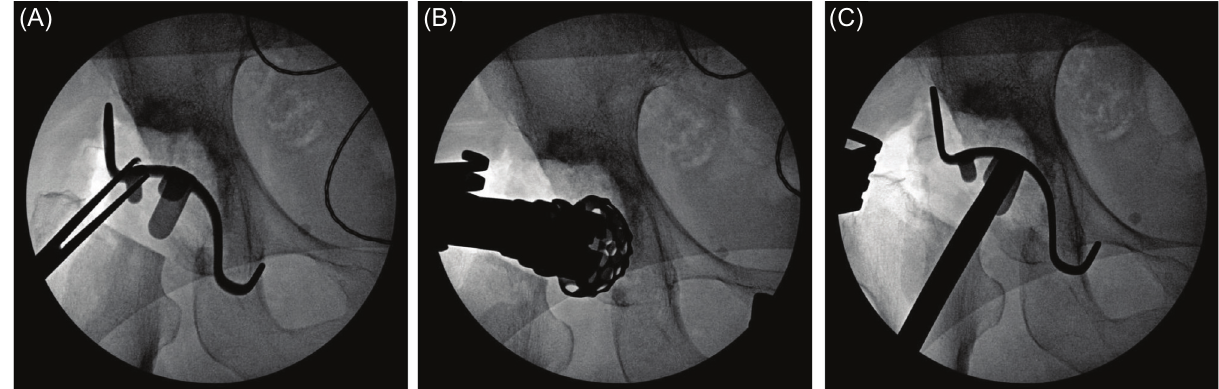
Figure 3. (A) The template of KT plate was placed, and the plate size and amount of the defect were confirmed. (B, C) When the template could not be sufficiently inserted, the osteophyte and acetabular floor region interfering with the template were trimmed using a small acetabular reamer, and fitting was